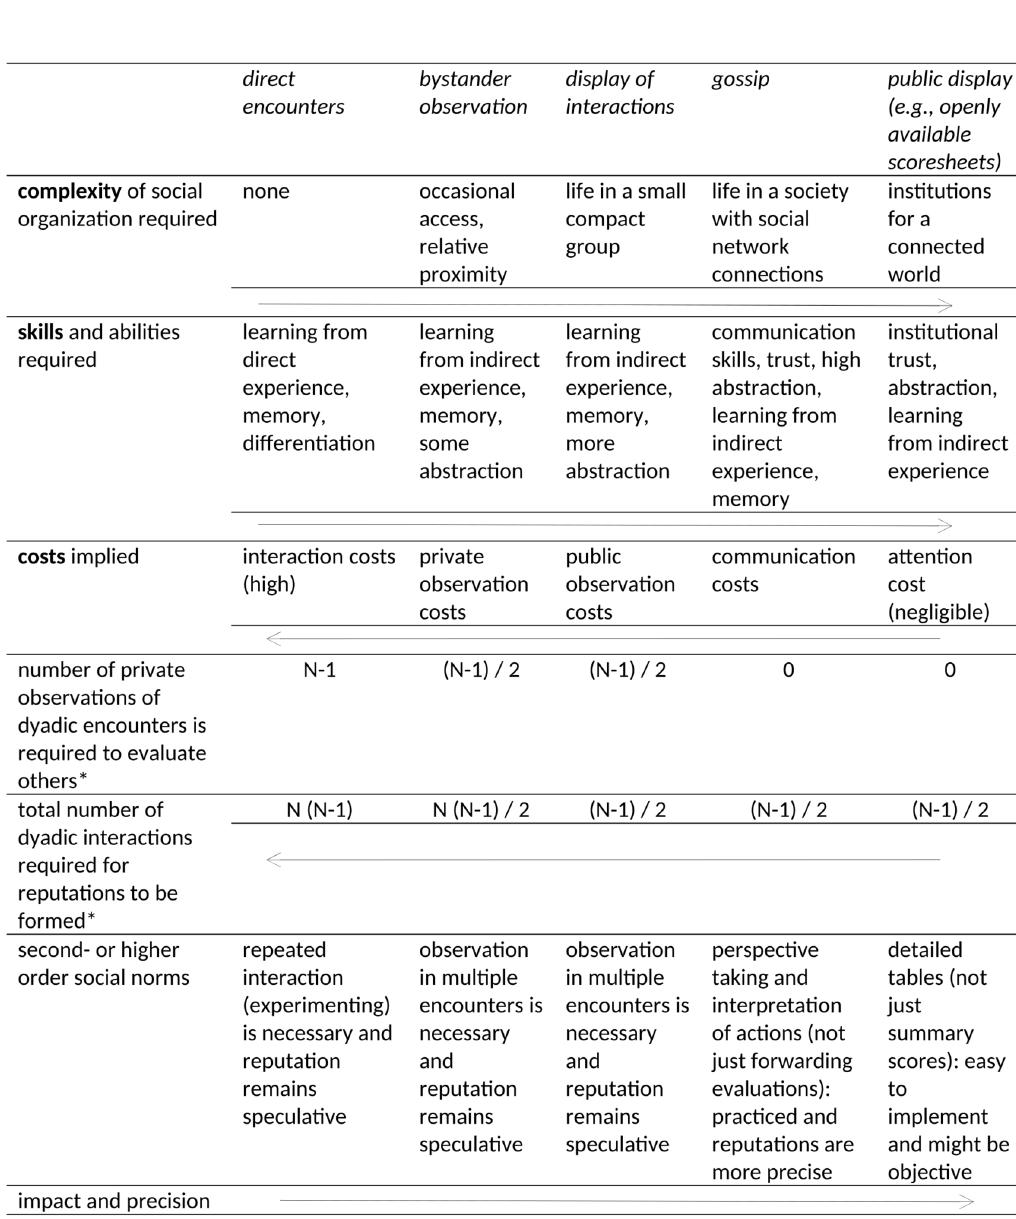
Table 1 . The construction of reputations through different ways *